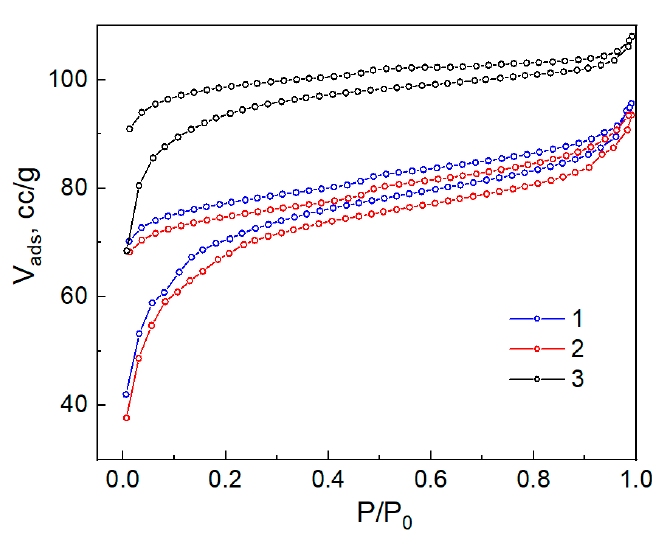
Figure 9. Isotherms of nitrogen adsorption at 77 K by synthesized nanocomposites, 1—NC1_10; 2—NC1_5; 3—NC2. Table 5. Parameters of the porous structure of synthesized nanocomposites according to nitrogen adsorption/desorption data.